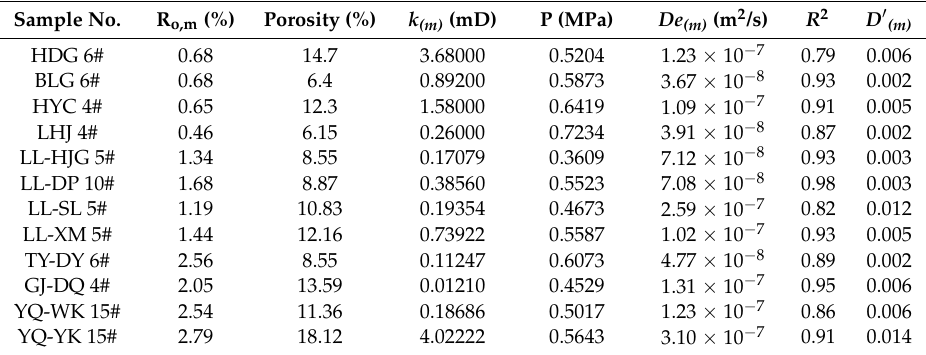
Table 4. Permeability and effective diffusion coefficient by experimental measurement.